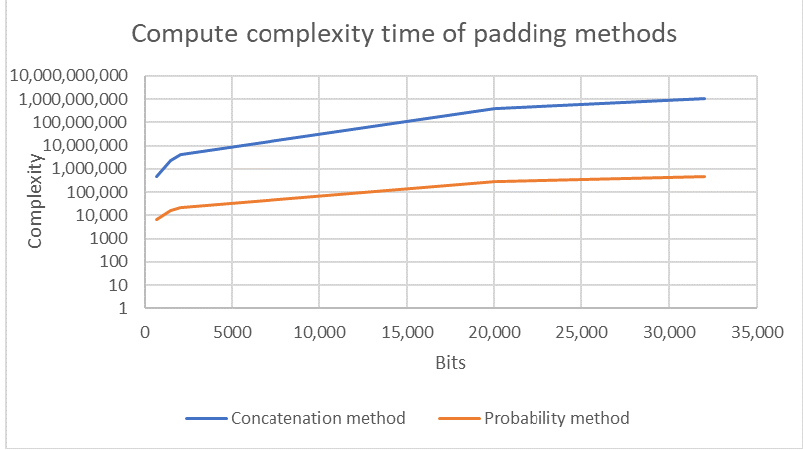
Figure 4. Complexity of probability and concatenation padding